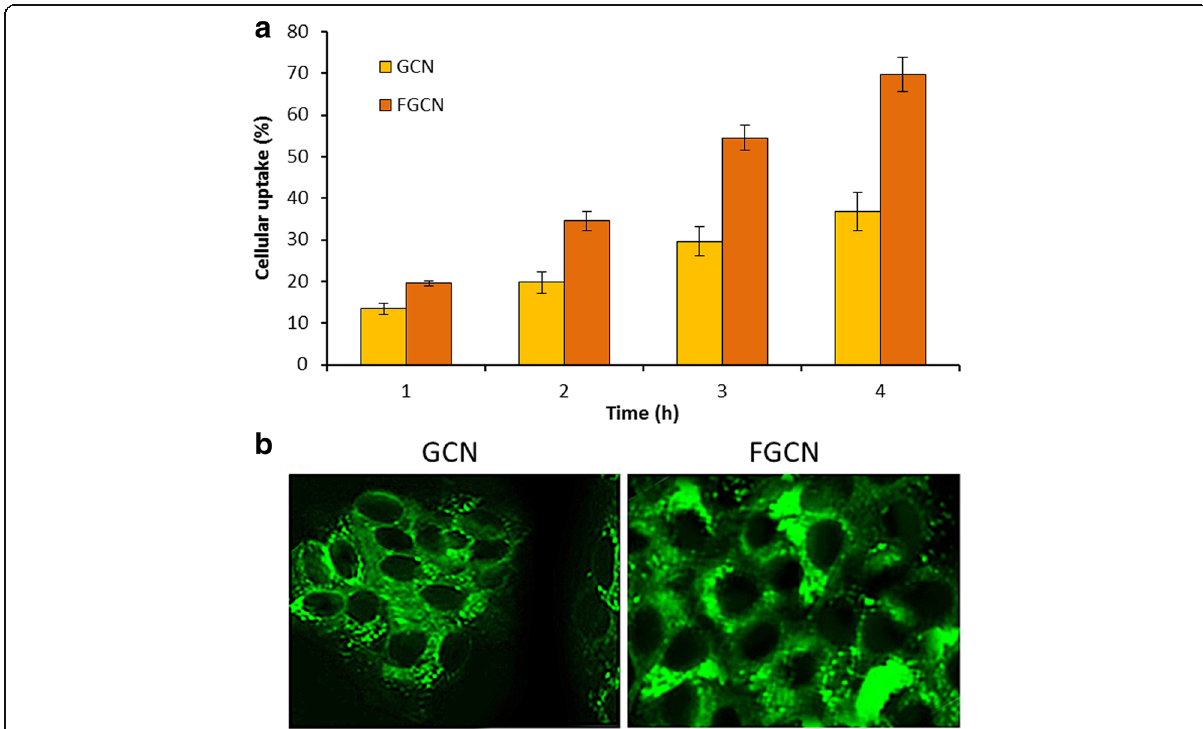
Fig. 4 Cellular uptake analysis of GCN and FGCN in HeLa Cervical cancer cells. a Quantitative analysis of cellular uptake of nanoparticles by fluorescence method. b Confocal laser scanning microscope (CLSM)-based cellular uptake analysis. Coumarin-6 was used as a fluorescent